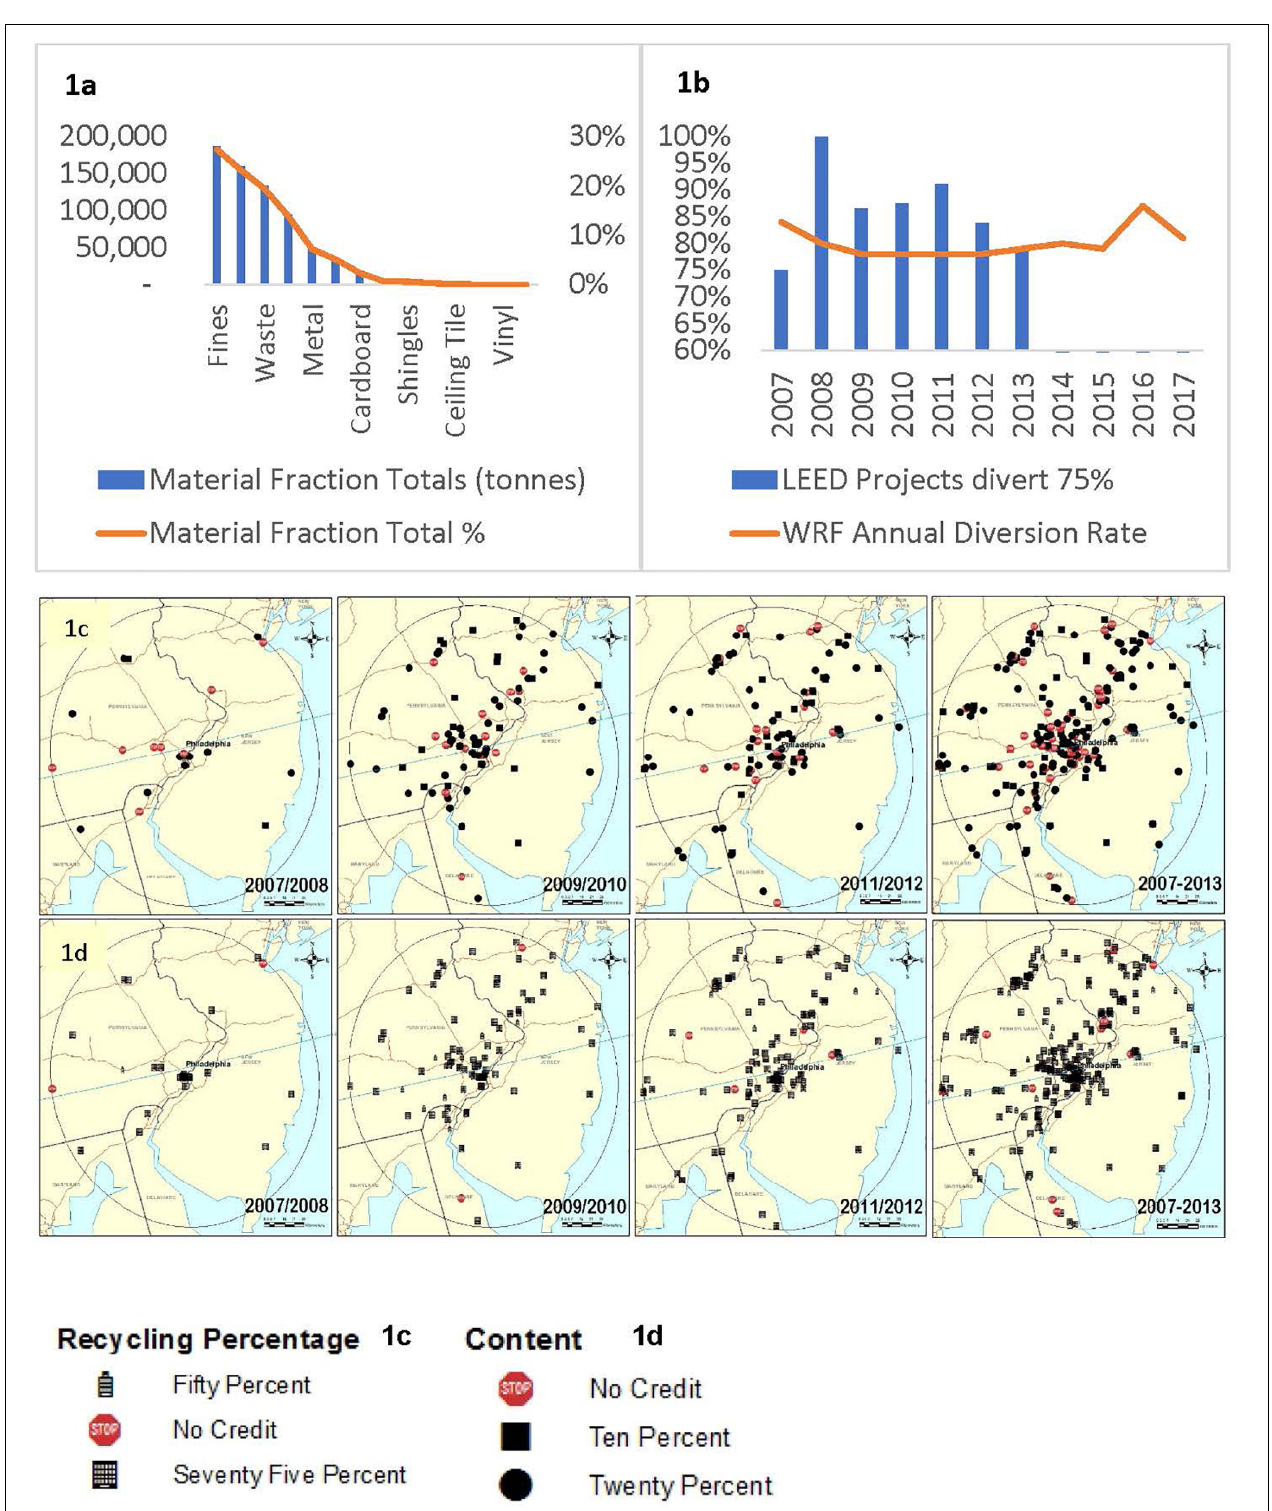
FIGURE 1 | (a–d) Recycling activities in the system boundary are indicated in two ways, WRF total flow and individual fractions and spatial relationship in the Philadelphia region with LEED activities. Because the data are from two different sources, they are difficult to compare; however, both demonstrate growth in waste diversion over the same spatiotemporal scale. This figure describes the individual fractions reported in the WRF data, as well as the spatial relationship reported in the LEED data. (Note: See Supplementary Material for full-sized maps and graphs Supplementary Figures S2a–j, 3a,b ).